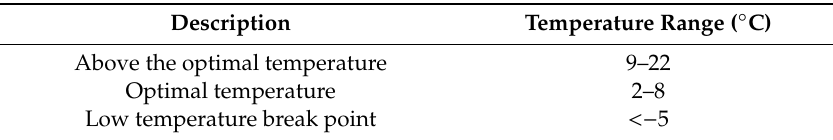
Table 3. Orange temperature